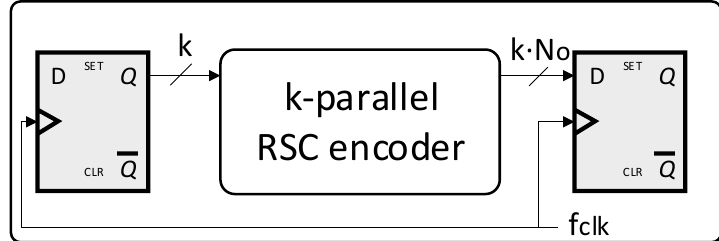
Figure 5. RSC encoder in a scenario with synchronous source and sink